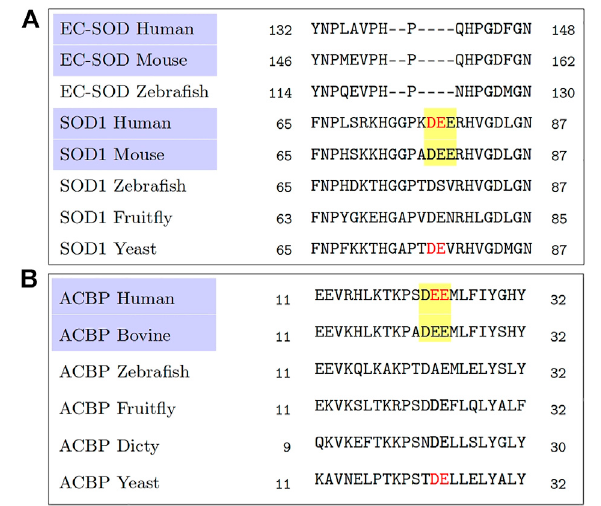
FIGURE 1 | A reanalysis of the multiple sequence alignments obtained from Cruz-Garcia et al. (2017). A comparison among the mammalian sequences, highlighted in purple, shows a common triacidic motif DEE (highlighted in yellow), rather than a diacidic motif (shown in red colored text) when comparing sequences across all species. (A) Multiple sequence alignment from homologs of SOD1. (B) Multiple sequence alignment from homologs of ACB1.